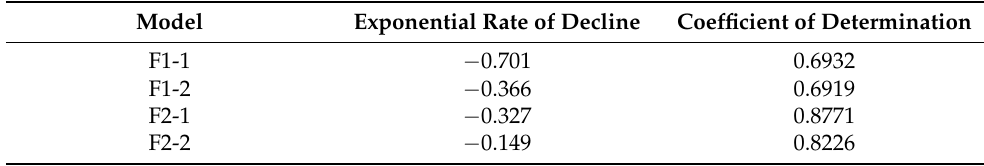
Table 3. Regression results for surface electrical resistivity.